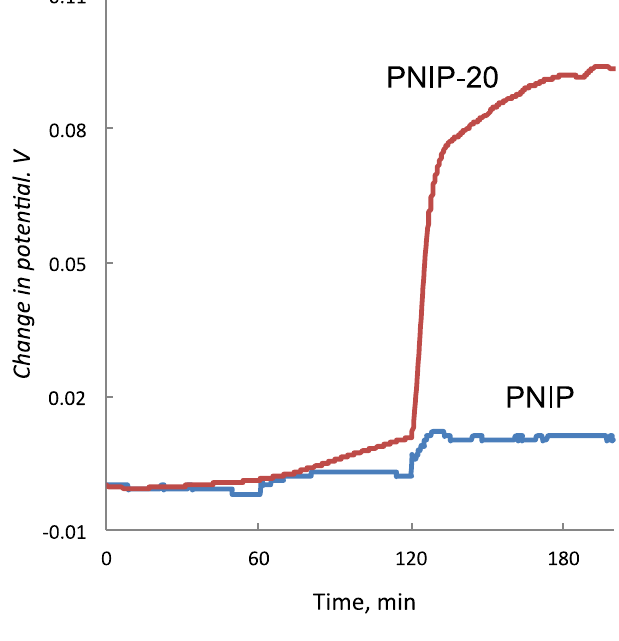
Figure 4. Time-course change in the surface potential of gold electrodes modified with PNIP-B-20 (red line) and PNIP (blue line) on addition of 10 g/L glucose at 27.5